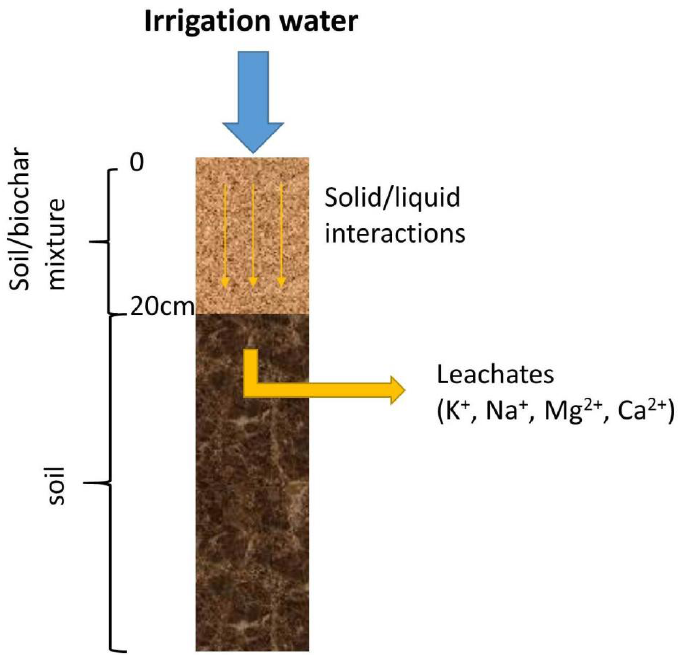
Figure 1. Graphic representation of the theoretical leaching model of soil columns by irrigation